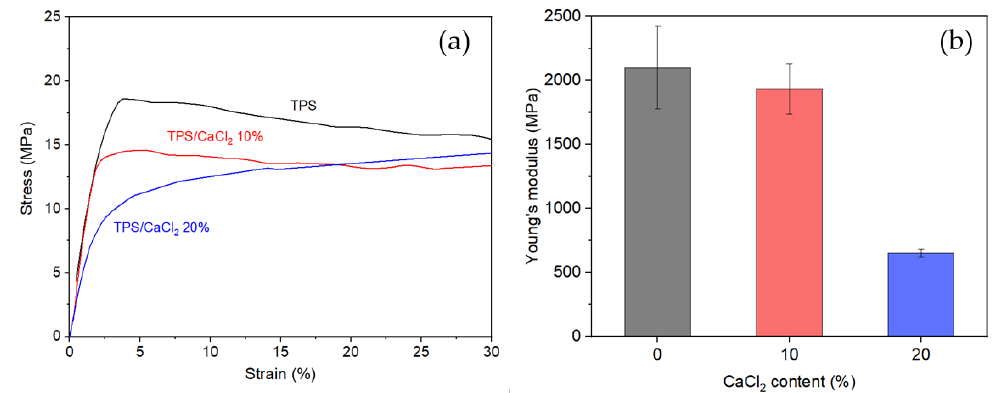
Figure 3. Effect of CaCl 2 addition on the mechanical properties of thermoplastic starch. ( a ) stress– strain curves and ( b ) Young’s modulus of virgin TPS, TPS/CaCl 2 10 wt% and TPS/CaCl 2 20 wt% composite films.